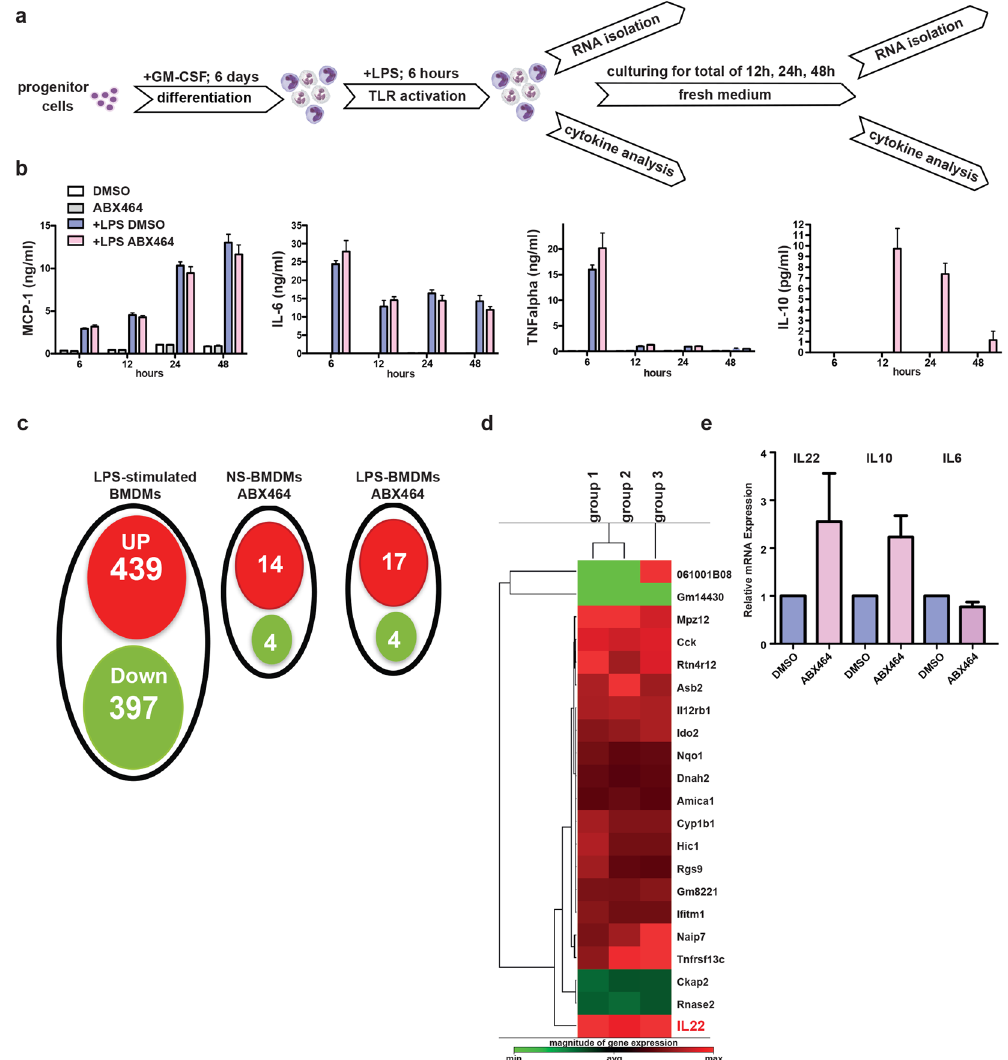
Figure 5. Effect of ABX464 on cytokine secretion and mRNA expression in BMDMs (a ) Bone marrow isolated cells were cultured for 6 days in the presence of GM-CSF (50ng/ml) to differentiate into macrophages. Cells were kept in culture for additional 3 days in the presence of ABX464 (5 µ M) or vehicle (DMSO) alone and for additional 6 hours stimulated with LPS (4 µ g/ml). Cells were then kept in normal medium for additional 42 hours. Cell aliquots for RNA isolation and supernatants were taken at time 6, 12, 24 and 48 hours. (b) Culture supernatants of the indicated cell cultures were analyzed by CBA for the content of MCP-1, IL-6, TNFalpha and IL-10 as described in Materials and Methods. (c) A Venn diagram displaying the number of inducible or repressible ( ≥ 1.5 log2-fold) genes after 6 hours stimulation of LPS (LPS-stimulated BMDMs), non-stimulated BMDMs treated with ABX464 (NS-BMDMs ABX464) or LPS-stimulated BMDMs treated with ABX464 (LPS- BMDMs ABX464). (d) Identification of genes regulated by ABX464 in LPS-stimulated BMDMs. RNA samples of three group of cells taken at time point 12 h were analyzed by RNAseq and each group represents the relative expression between ABX464 and control (DMSO) treated samples. Only those genes are represented that were differentially expressed in each group. (e) Validation of elevated transcript levels of IL-22 in ABX464-treated LPS-stimulated BMDMs by